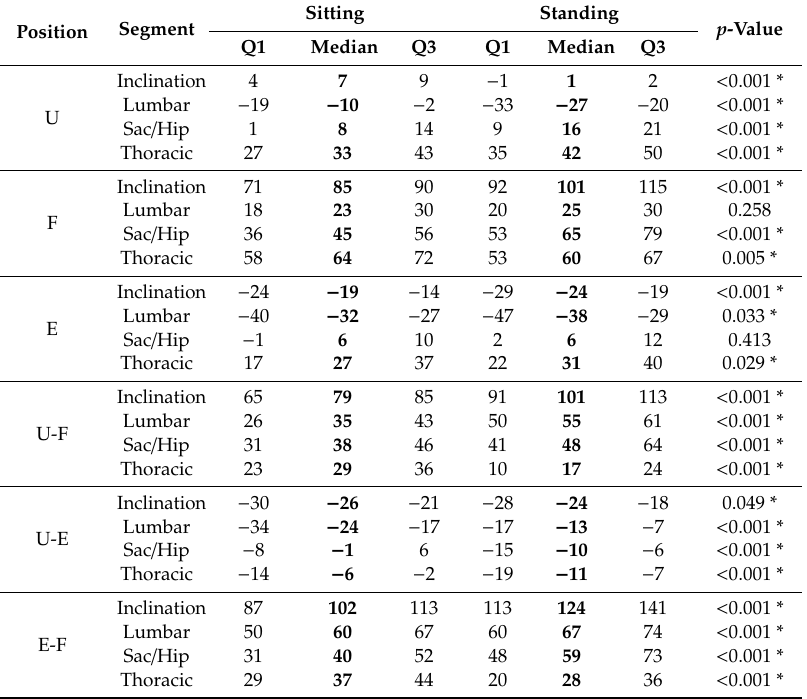
Table 1. Median and interquartile range of total inclination, lumbar-, thoracic- and sacrum / hip inclinations in degrees measured in standing and sitting positions in upright (U), flexion (F), extension (E) and estimated range of motion from upright to flexion (U-F), upright to extension (U-E) and extension to flexion (E-F) ( n = 91).